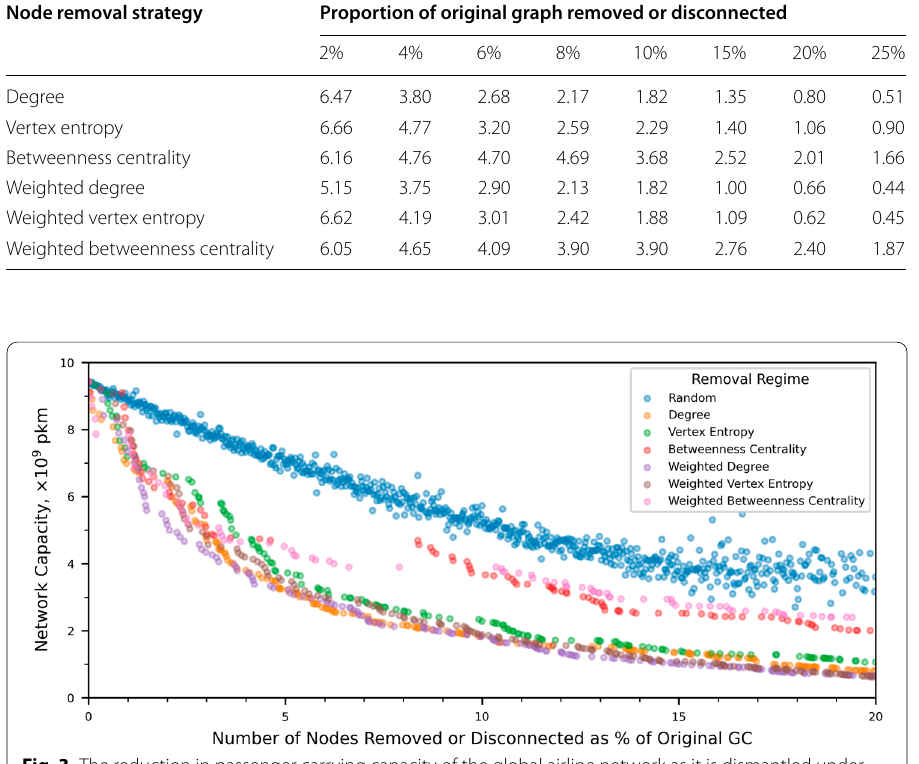
Fig. 3 The reduction in passenger carrying capacity of the global airline network as it is dismantled under different node removal regimes. Random node removal causes a smaller reduction than targeted methods. Under targeted removal the network capacity reduces by half when only approximately 3–4% or the network has been removed or